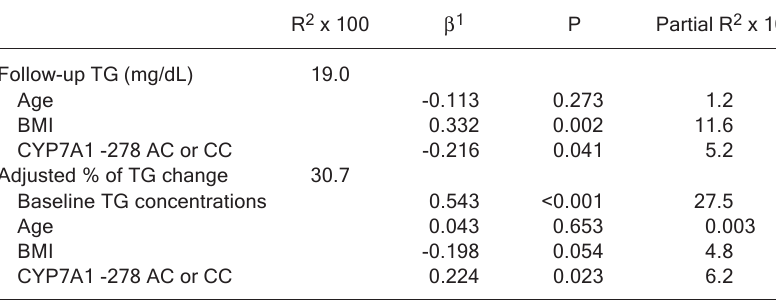
Table 4. Multiple linear regression analyses for follow-up triglyceride concentrations and adjusted percent triglyceride